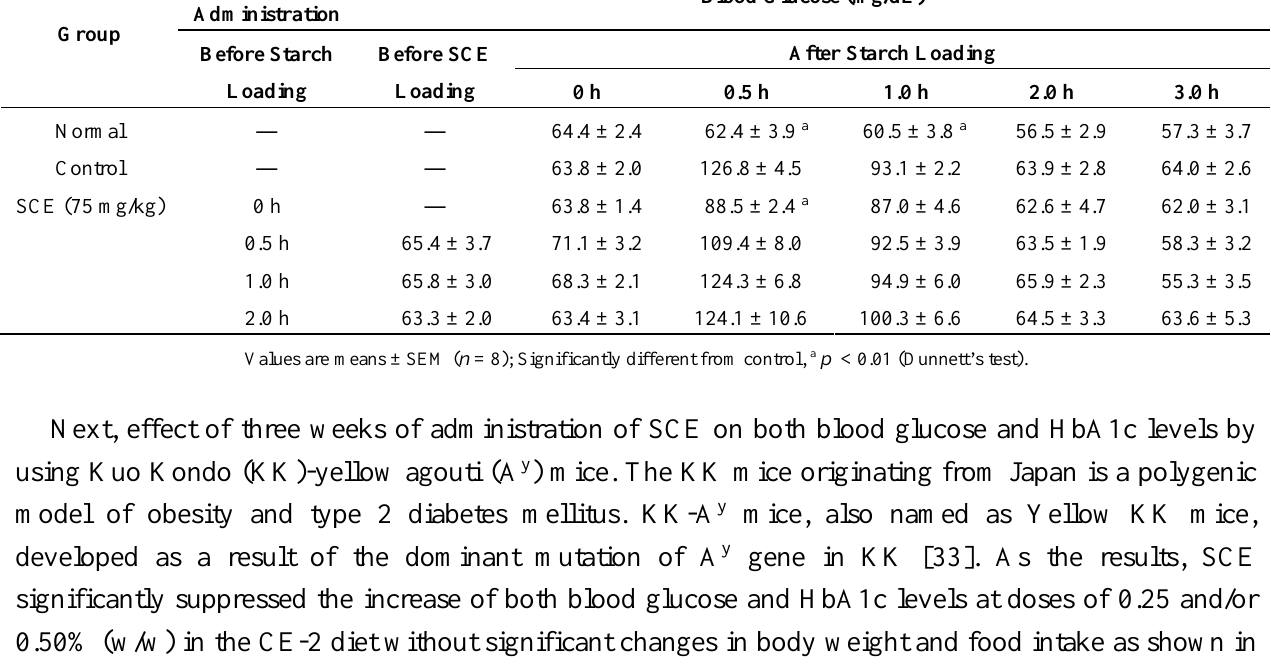
Values are means ± SEM ( n = 8); Significantly different from control, a p < 0.05, b p < 0.01 (Dunnett’s test); iAUC: incremental area under the curve; ED 50 : effective dose 50. Table 3. Effects of SCE on blood glucose levels in SCE-pretreated starch-loaded rats.